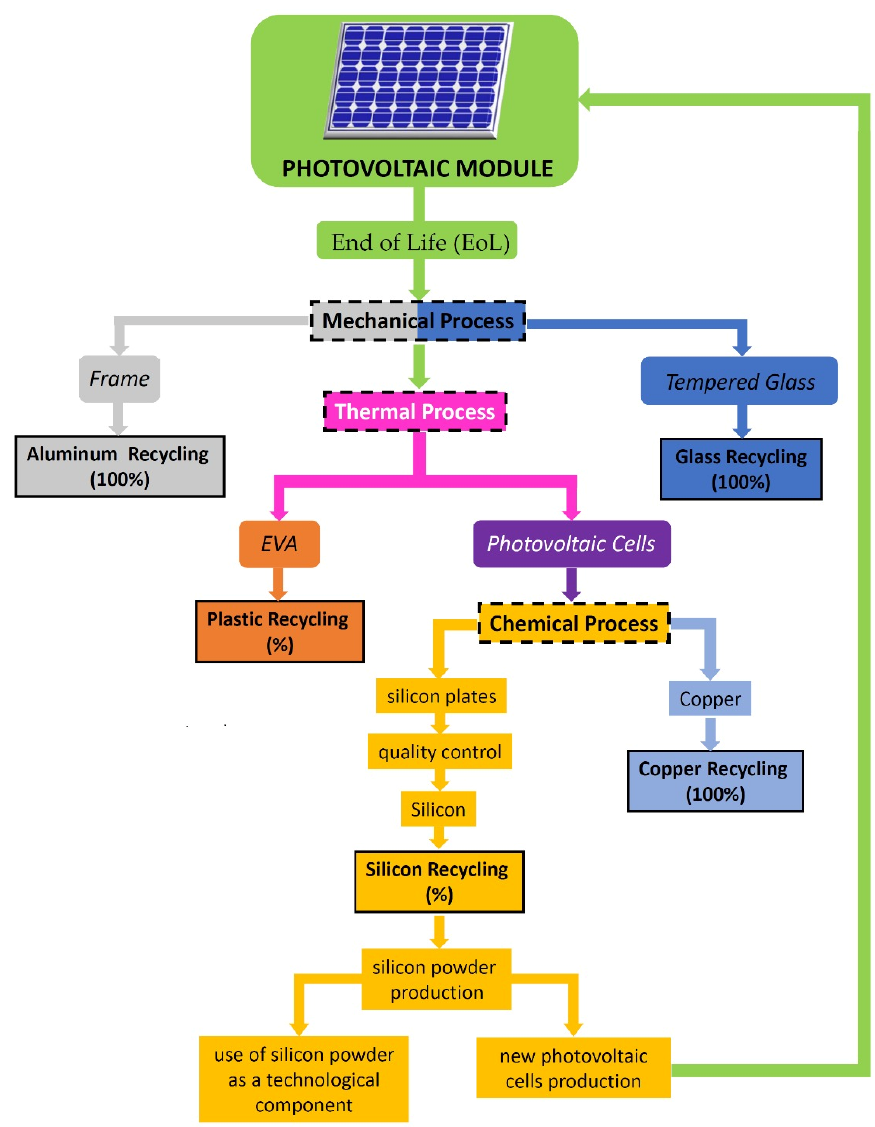
Figure 9. Logical scheme for silicon-based PV module total recycling.